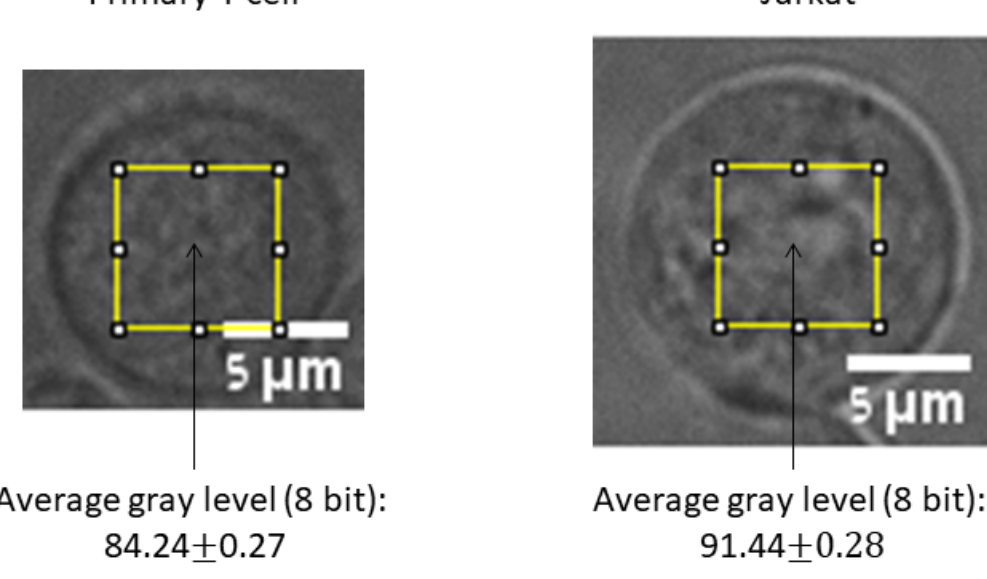
Figure 9. Representative images of a primary T cell and a Jurkat cell with the 40 × 40 pixels ROIs in their centers. The average gray levels in the ROIs of each group of cells: Primary T cells (n = 219) and Jurkjat cells (n = 161) are presented below the corresponding cell type.